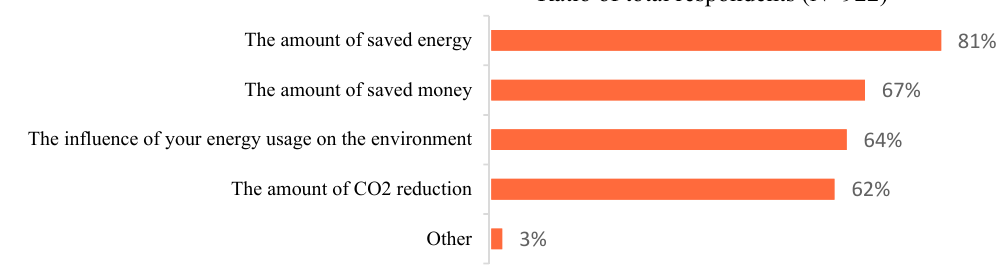
Figure 11. List of possible information to see on the display of the office energy monitor.